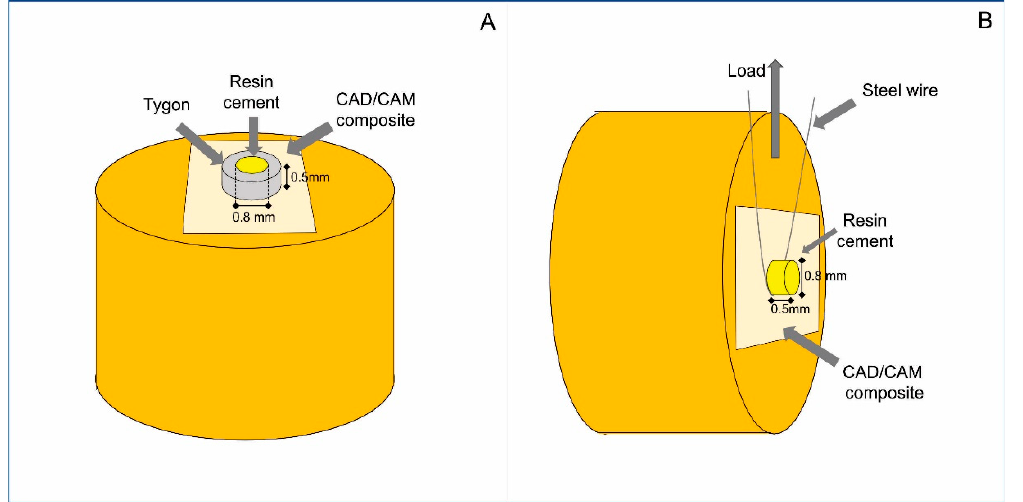
Figure 2. Schematic drawing of the SBS test used in the current study. ( A ) Specimen preparation on the CAD-CAM composite surface; ( B ) Specimen positioned for the SBS